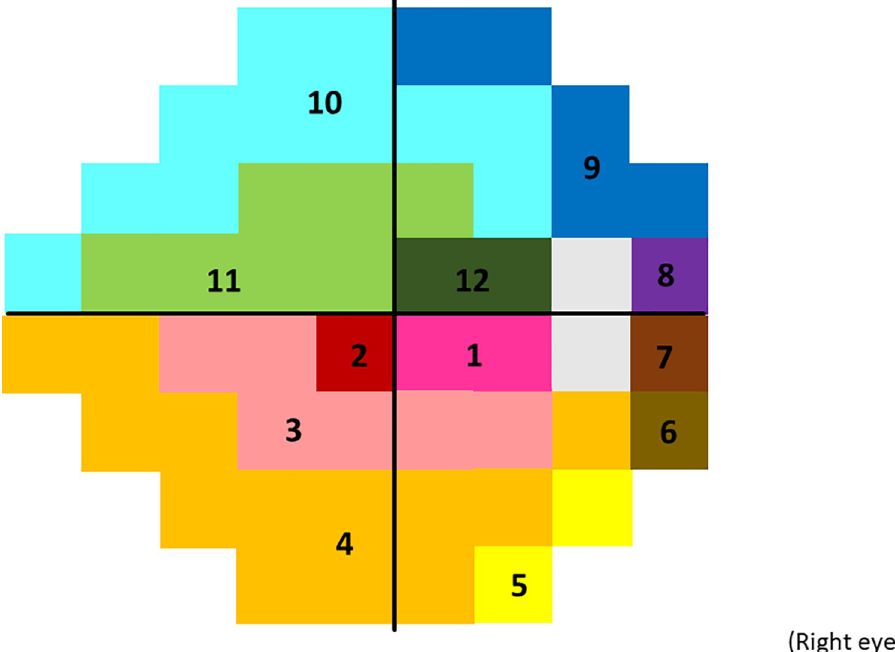
Fig 1. Twelve sectors correspond to 30 degrees optic disc angles. The visual field was divided into 12 sectors corresponding to 30 degrees of optic disc angles, based on the structure-function mapping by Garway-Heath et al. [18].